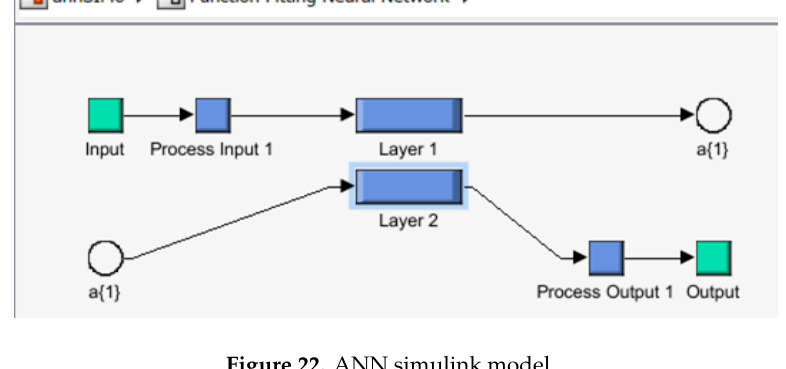
Figure 22. ANN simulink model.